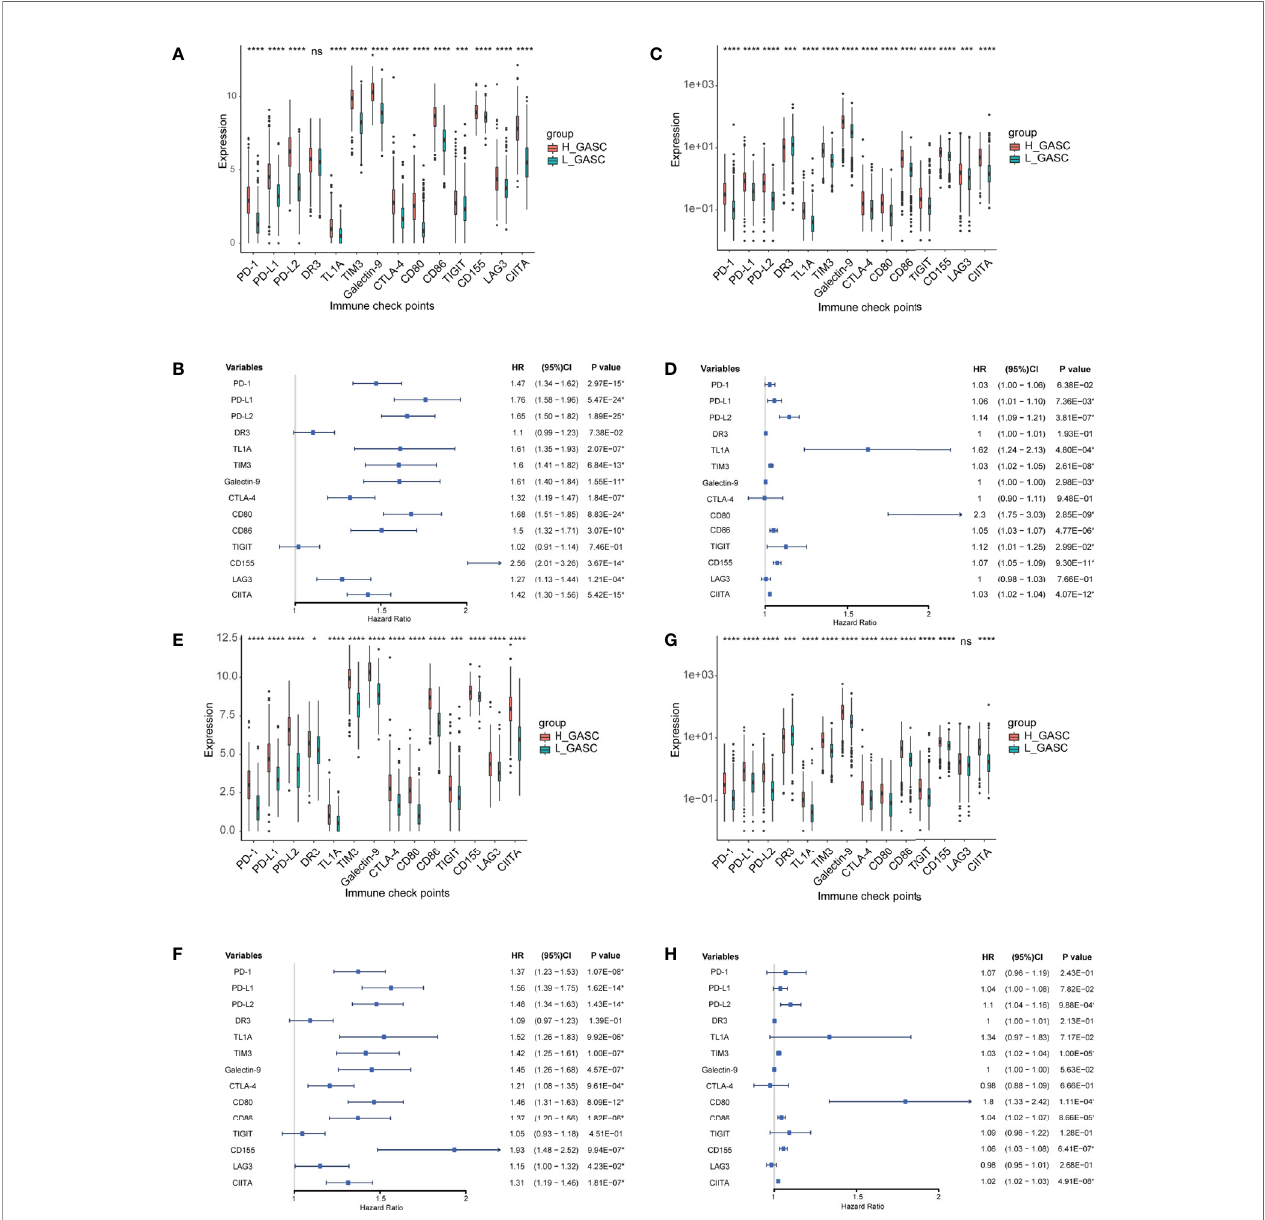
FIGURE 10 | Associations between GASCs and expression of ICPs. (A, C, E, G) Bar charts illustrating the differences of ICP ’ expressions between high- and low- GASC groups in all glioma population ( A for TCGA and C for CGGA) and high-grade glioma population ( E for TCGA and G for CGGA). (B, D, F, H) Forest plots of univariate Cox regression analysis of ICP ’ expressions in all glioma population ( B for TCGA and D for CGGA) and high-grade glioma population ( F for TCGA and H for CGGA). ns: p > 0.05, * p ≤ 0.05, *** p ≤ 0.001, **** p ≤